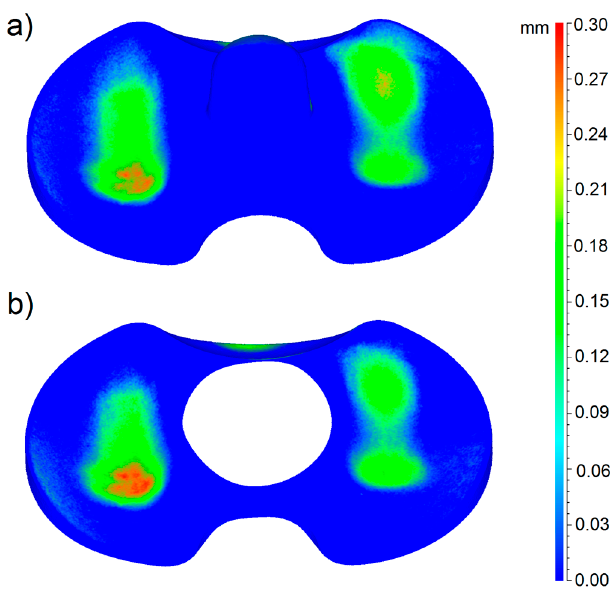
Figure 7. 3D wear map of the fixed meniscus #2: in part a , the 3D wear map of the entire prosthesis is shown; in part b , the 3D wear map of the butterfly region is shown.